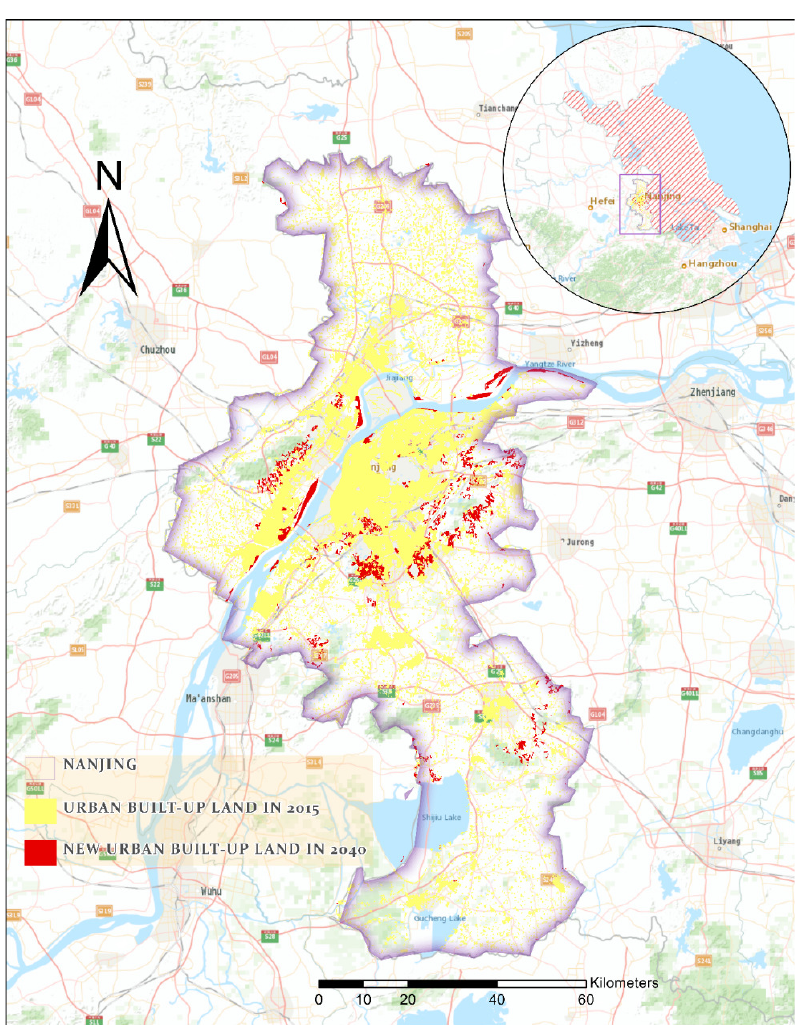
Figure 5. Prediction map of new urban built‐up land in 2040 in Nanjing. scattered and orderly around the urban built‐up land in 2015. In addition to the central city area, some future urban areas are distributed in the new urban area on the north bank of the Yangtze River while a small number of areas are distributed in the suburban area in the south of the city. The predicted development results are broadly consistent with Nanjing’s comprehensive plan for 2040 in the direction, area, scale, and other aspects of the growth plot. However, in terms of development